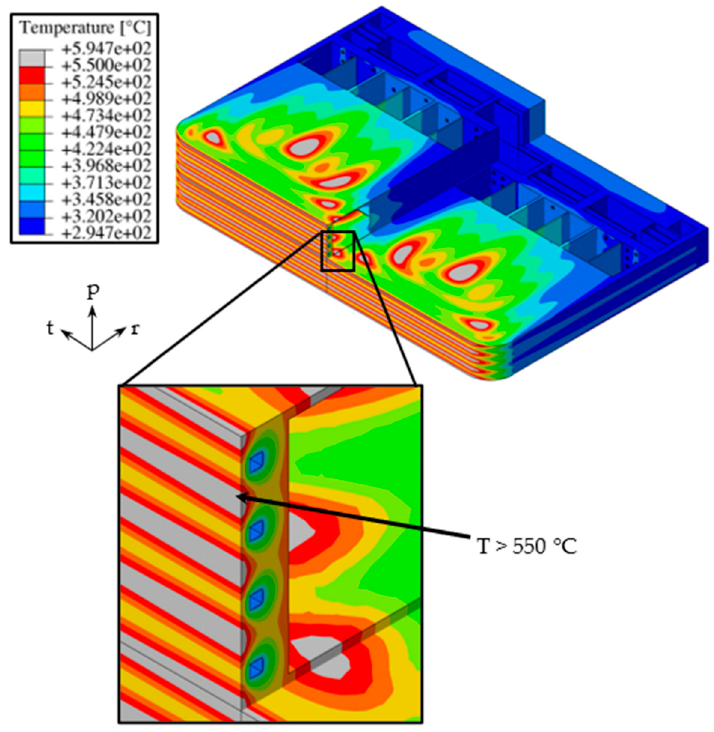
Figure 6. Thermal field raised within the Eurofer domain of the O6 region.